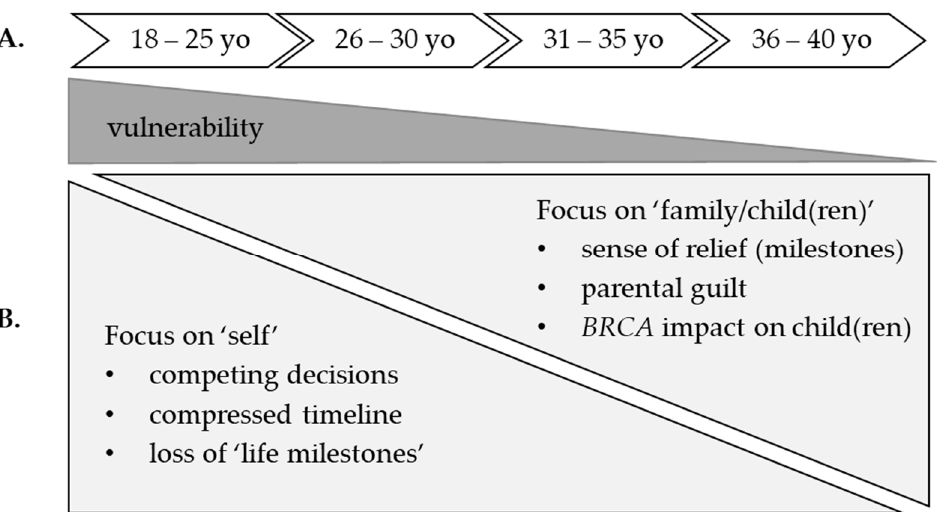
Figure 2. Schematic depicting the template theme, sub-themes, and dimensions in women of reproductive age ( ≤ 40 year-old [yo]). ( A ) The template theme from the quantitative findings related to increased ‘vulnerability’ in women of reproductive age. Vulnerability (dark tapered triangle) was the highest in younger women but still present in older reproductive-aged women. ( B ) The sub-themes (triangles) represented a negotiation or bargaining between ‘self’ and ‘others’. Younger BRCA + women tended to focus on the ‘self’, including dimensions (bullets) relating to: (i) balancing cancer risk and fertility goals, (ii) feeling a sense of urgency to make major life decisions (racing against a “cancer clock”) and (iii) concerns about possibly not being able to have children/breastfeed. Older BRCA + women tended to focus on ‘family/child(ren)’ including dimensions relating to: (i) feeling relieved at having met ‘life milestones’, (ii) guilt for possibly passing BRCA to offspring and (iii) concern about the impact BRCA might have on their child(ren)’s life.